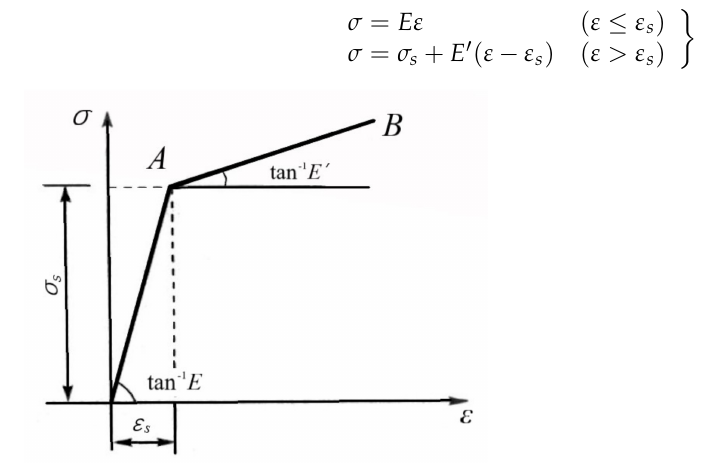
Figure 4. Elastoplastic linear strengthening model.